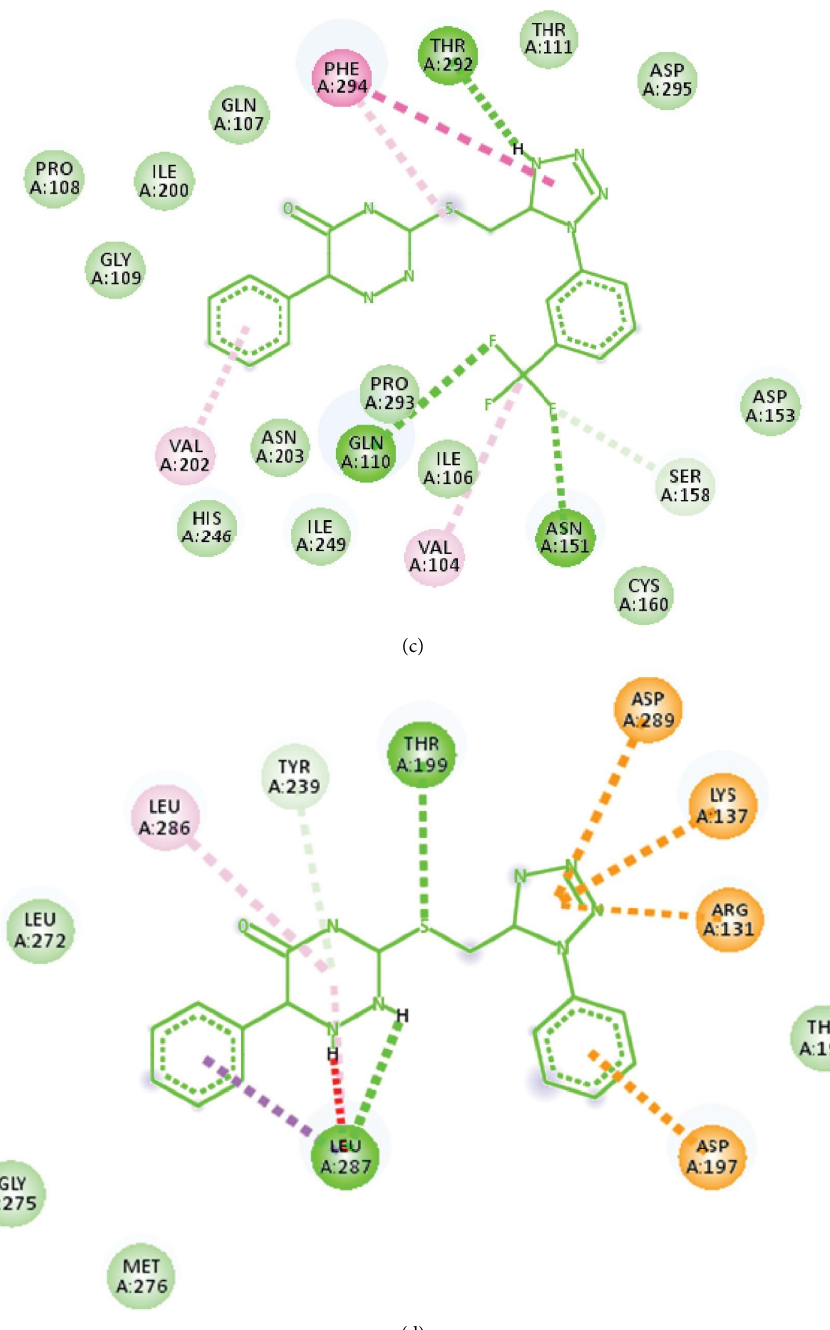
Figure 5: Molecular surface representation showing the four final drug candidates lying within the binding pockets of the target protein (PDB ID